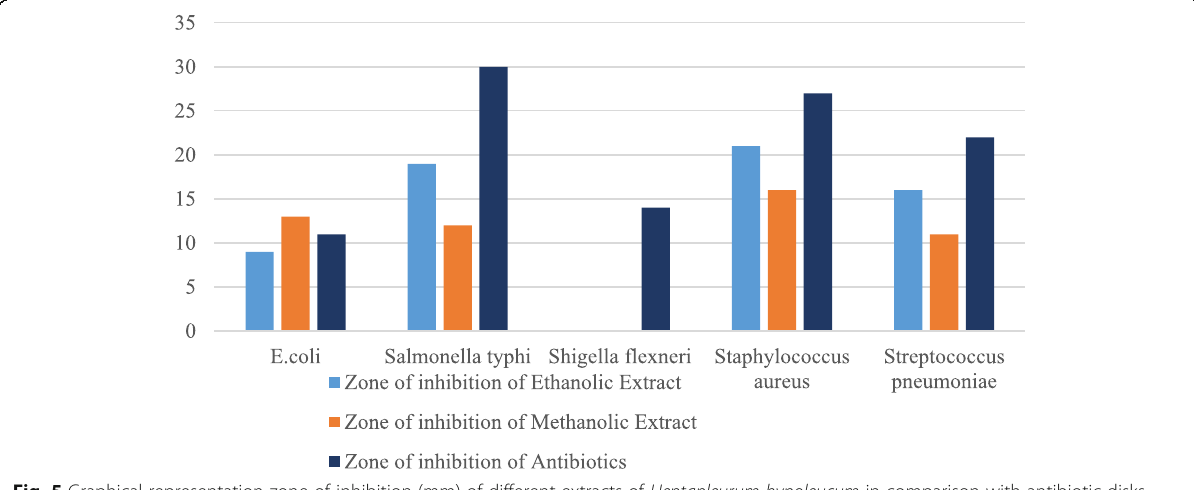
Fig. 5 Graphical representation zone of inhibition (mm) of different extracts of Heptapleurum hypoleucum in comparison with antibiotic disks against some disease-causing microorganisms. Ethanolic extract showed the highest zone of inhibition against Staphylococcus aureus (21